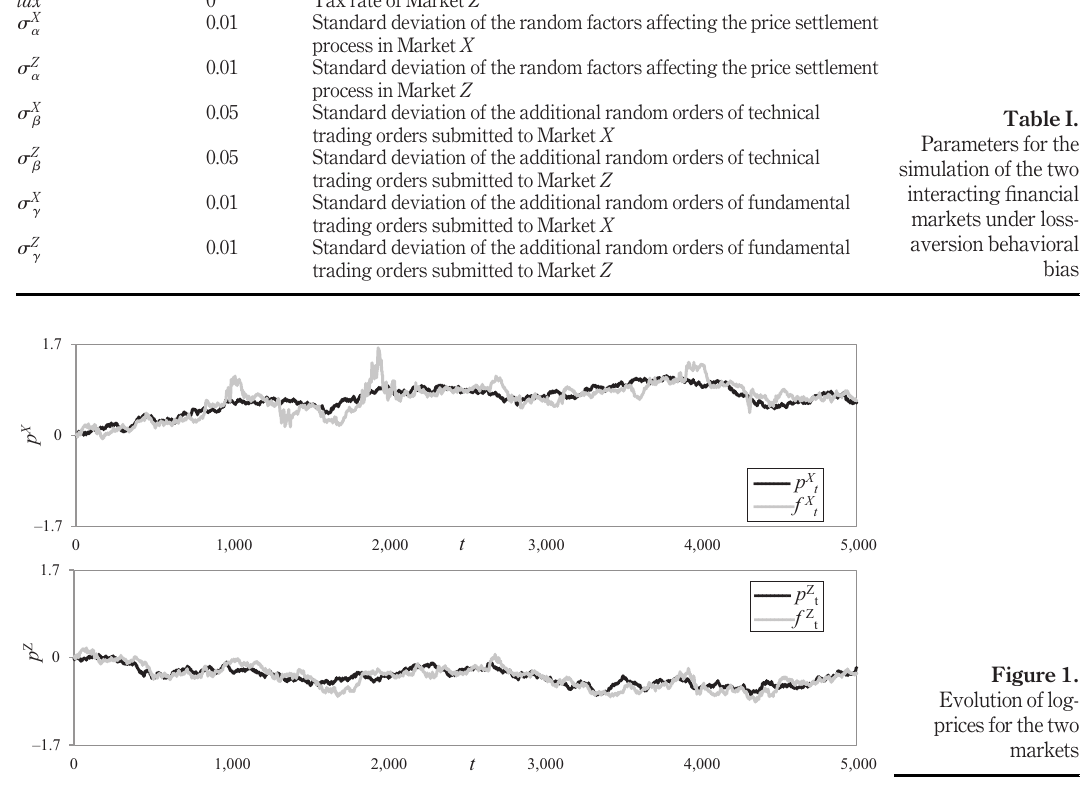
Table I. Parameters for